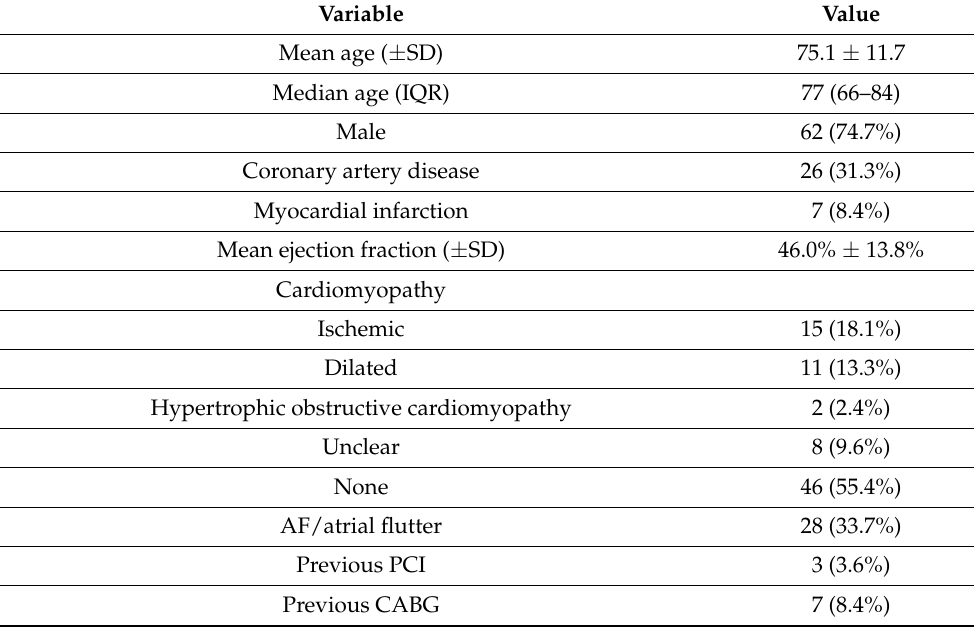
Table 1. Patient characteristics and comorbidities ( n =